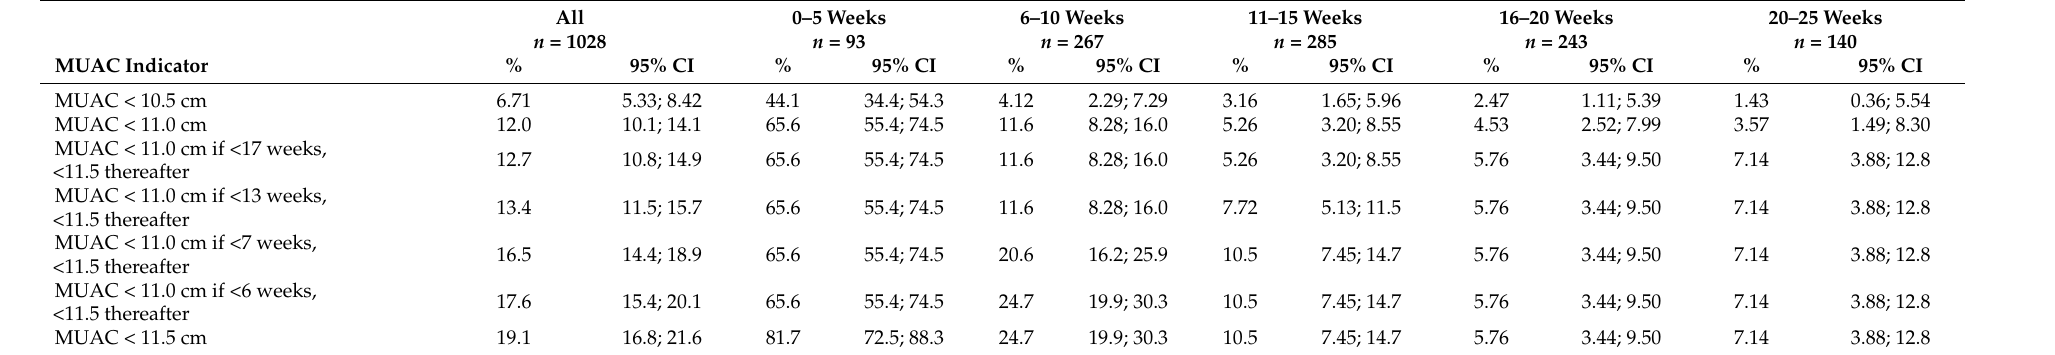
Table 3. Proportion of infants aged under six months with low MUAC as defined by different thresholds.